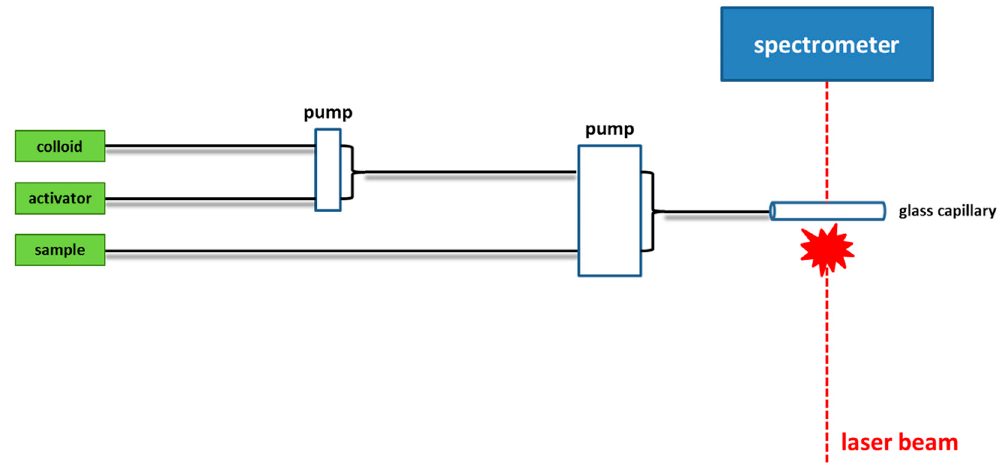
Figure 1. Schematic diagram of the flow cell used for quantitative analysis of mitoxantrone in clinical serum samples, adapted from [45].